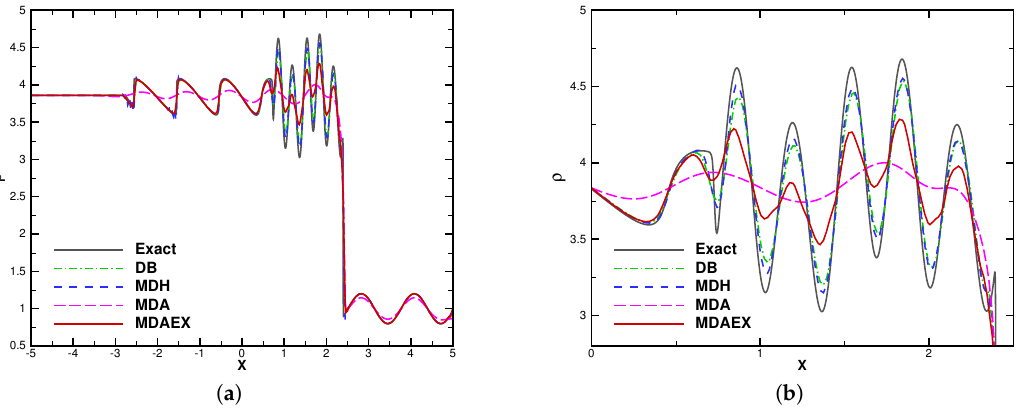
Figure 9. Density solution for the one-dimensional Shu–Osher problem with 200 elements at t = 1.8, P 2. ( a ) Overview; ( b ) zoomed in results.